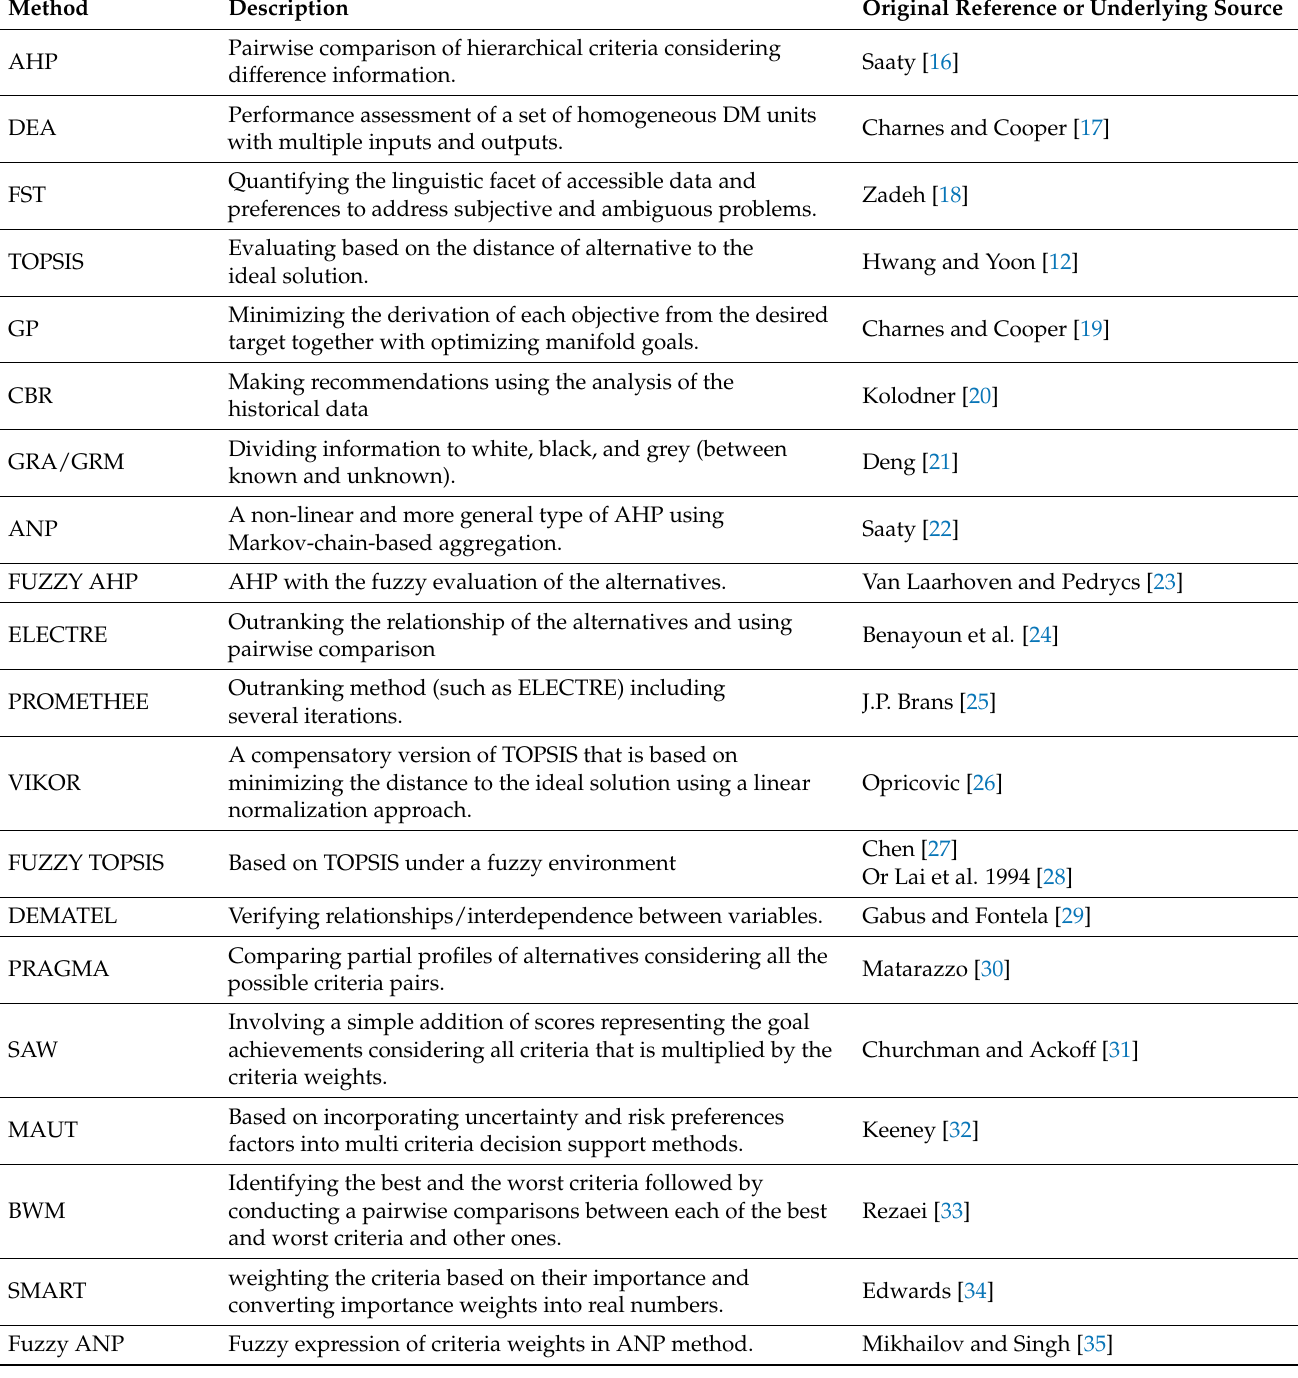
Table 4. Description of the Main MCDM